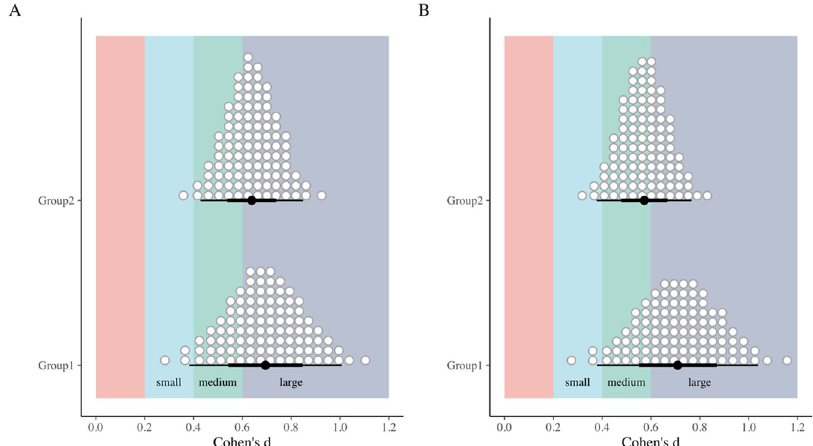
Fig 3. Posterior distribution for the absolute effect sizes (Cohen’s d) of the intervention for Understanding scores (A) and No Concept scores (B) with the median and 66% and 95% CI (Effect size labels according to Calin-Jageman and Cumming [85]). Group 1 = intervention between Occ1 & Occ2; Group 2 = intervention between Occ2 & Occ3.